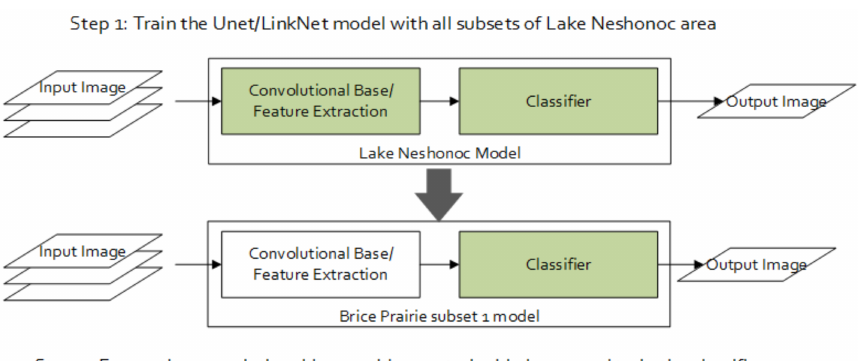
Figure 5. Workflow of Experiment # 2 showing the Lake Neshonoc model implementation with the Brice Prairie